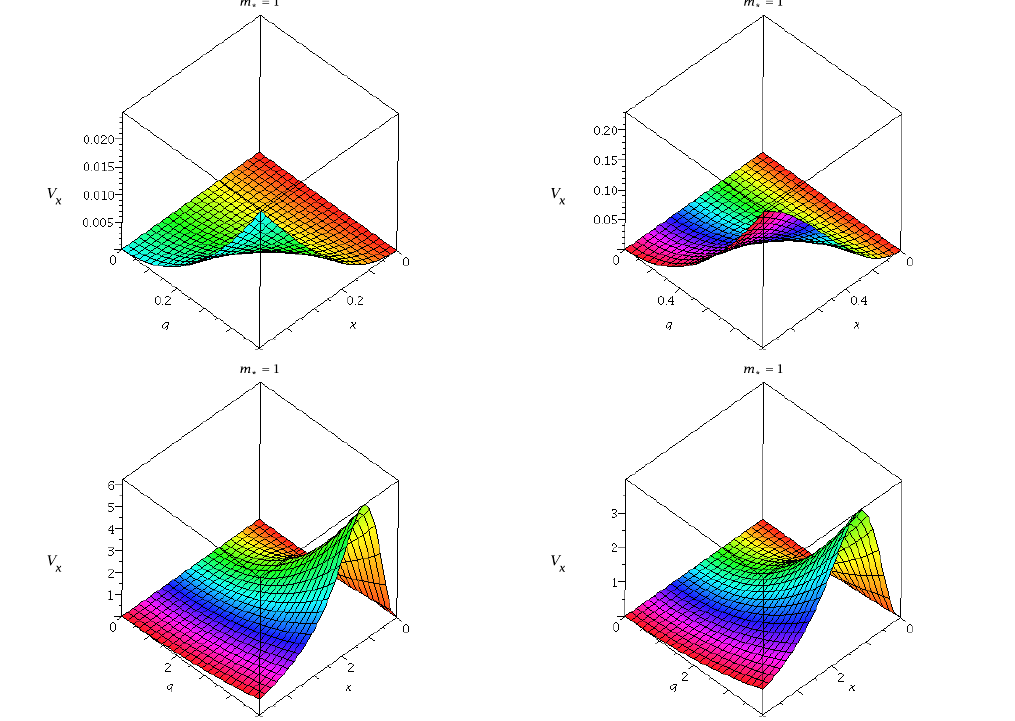
Figure 8. The figure depicts the variation of V x with x and q for ABG